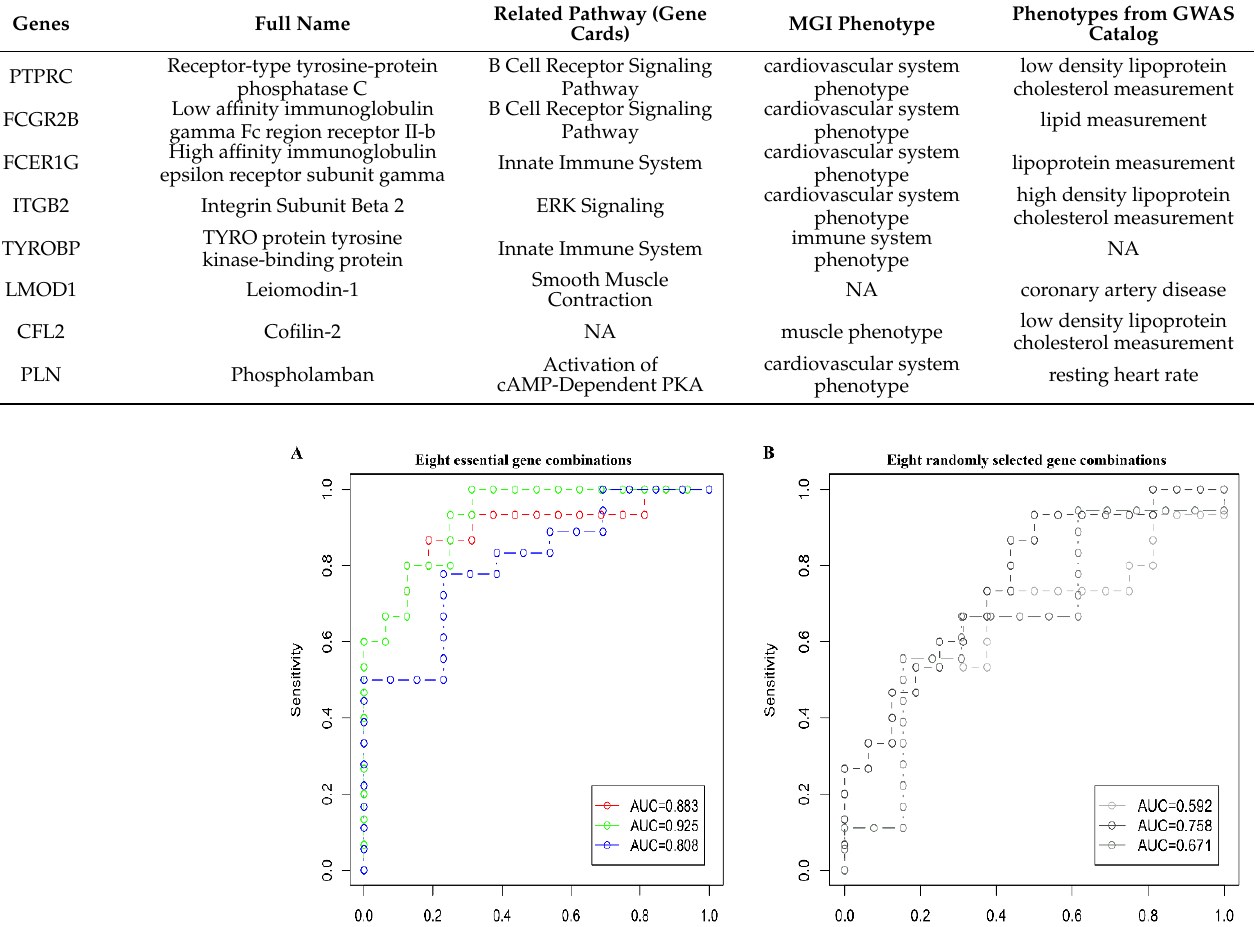
Table 2. The detailed annotation of key genes based on MGI and GWAS Catalog databases.